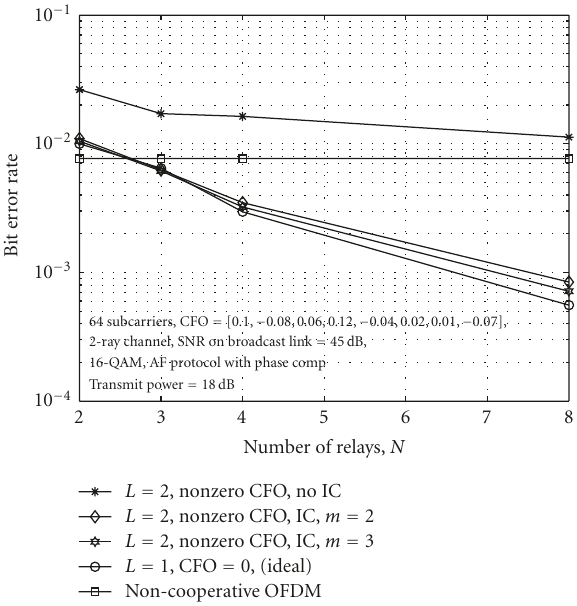
Figure 6: BER performance as a function of number of relays for CO-SFBC-OFDM on frequency-selective fading ( L = 2). M = 64, Transmit power = 18 dB per bit. CFO = [0.1, − 0.08, 0.06, 0.12, − 0.04, 0.02, 0.01, − 0.07], 16-QAM, SNR on broadcast links = 45dB. G 2 , G 3 , G 4 and G 8 codes with rates 1, 3/4, 3/4 and 1/2 are used. AF protocol and phase compensation at the